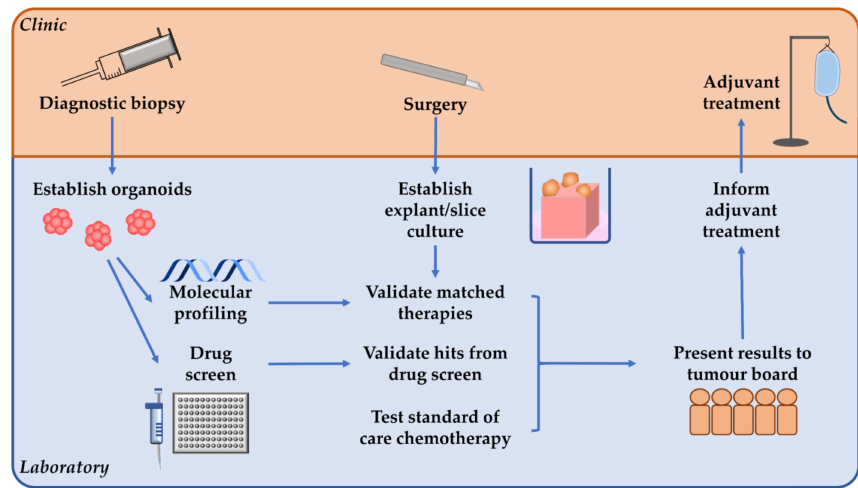
Figure 3. A proposed personalised medicine pipeline for patients with surgically resectable pan- creatic ductal adenocarcinoma. If diagnostic biopsy is performed prior to surgery, organoids can be established to allow molecular profiling and drug screens to be performed. Then tumour ex- plant/slice culture can be established from tissue obtained during surgery, which could allow any hits identified from the organoid molecular profiling or drug screen to be validated. Ex vivo explant/slice culture can also be used to test standard of care chemotherapy which can be particularly useful when no matched therapies are identified. These results can then be presented to a tumour board to guide personalised adjuvant